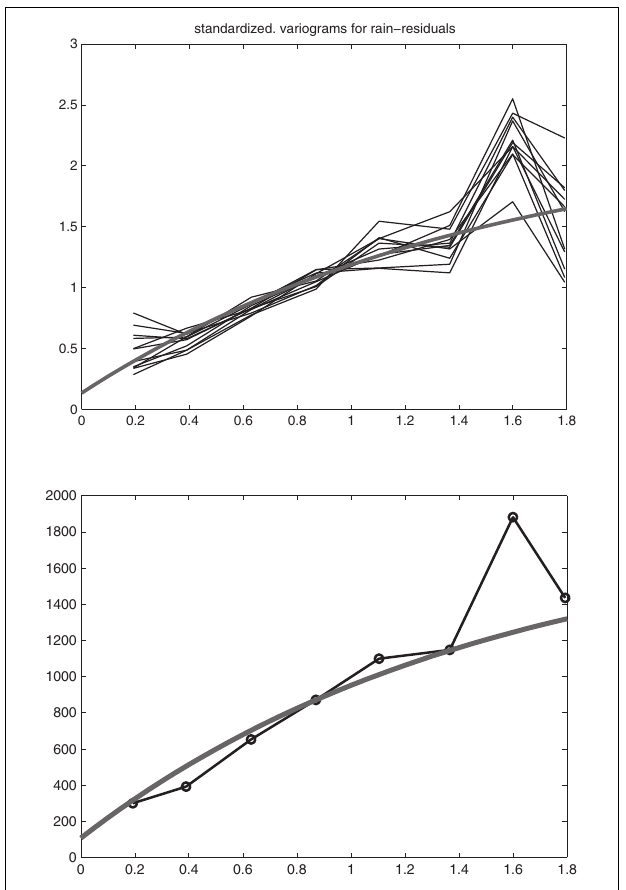
FIGURE 5 | Above: Polar spectral distribution function and its approximation (gray). Below: True covariance function (black) and its worst approximation